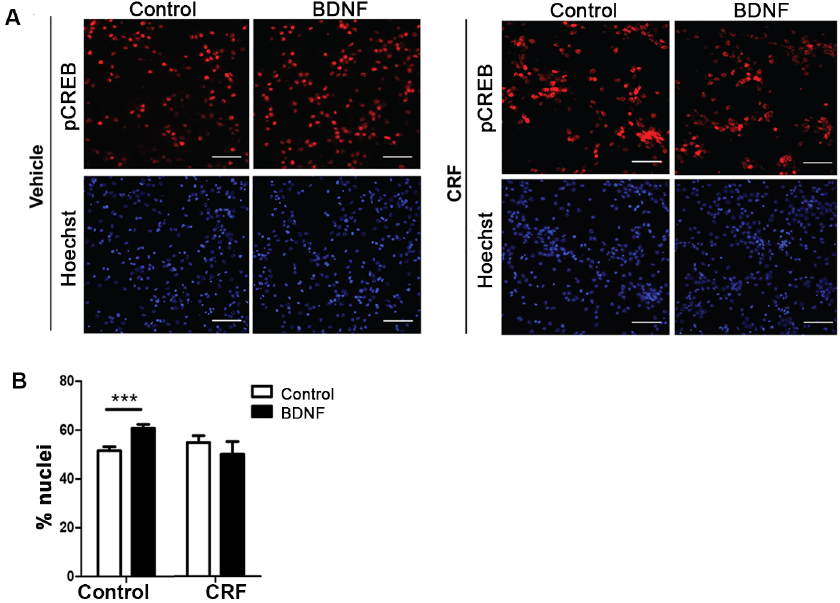
Fig 3. Activation of CREB Pathways. Neurons that were cultured in microfluidic chambers were treated with BDNF (50 ng/ml) for 0.5hr. Neurons were fixed and stained for pCREB and the nuclei were stained with Hoechst dye. (A) Representative images are shown (scale bar = 50 μ M). (B) Quantitative analysis of the percentage of nuclei that were pCREB-positive (p = 0.005, n = 10 images).